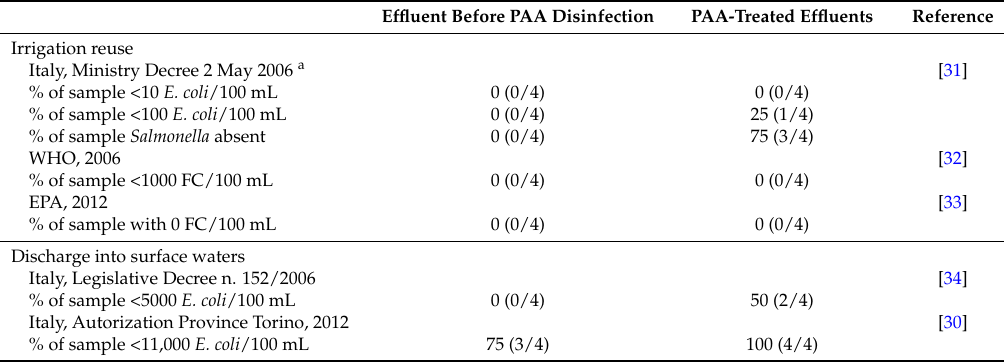
Table 6. Frequency (%) of compliance of samples with Italian limits and International Guidelines for the re-use in irrigation and discharge into surface